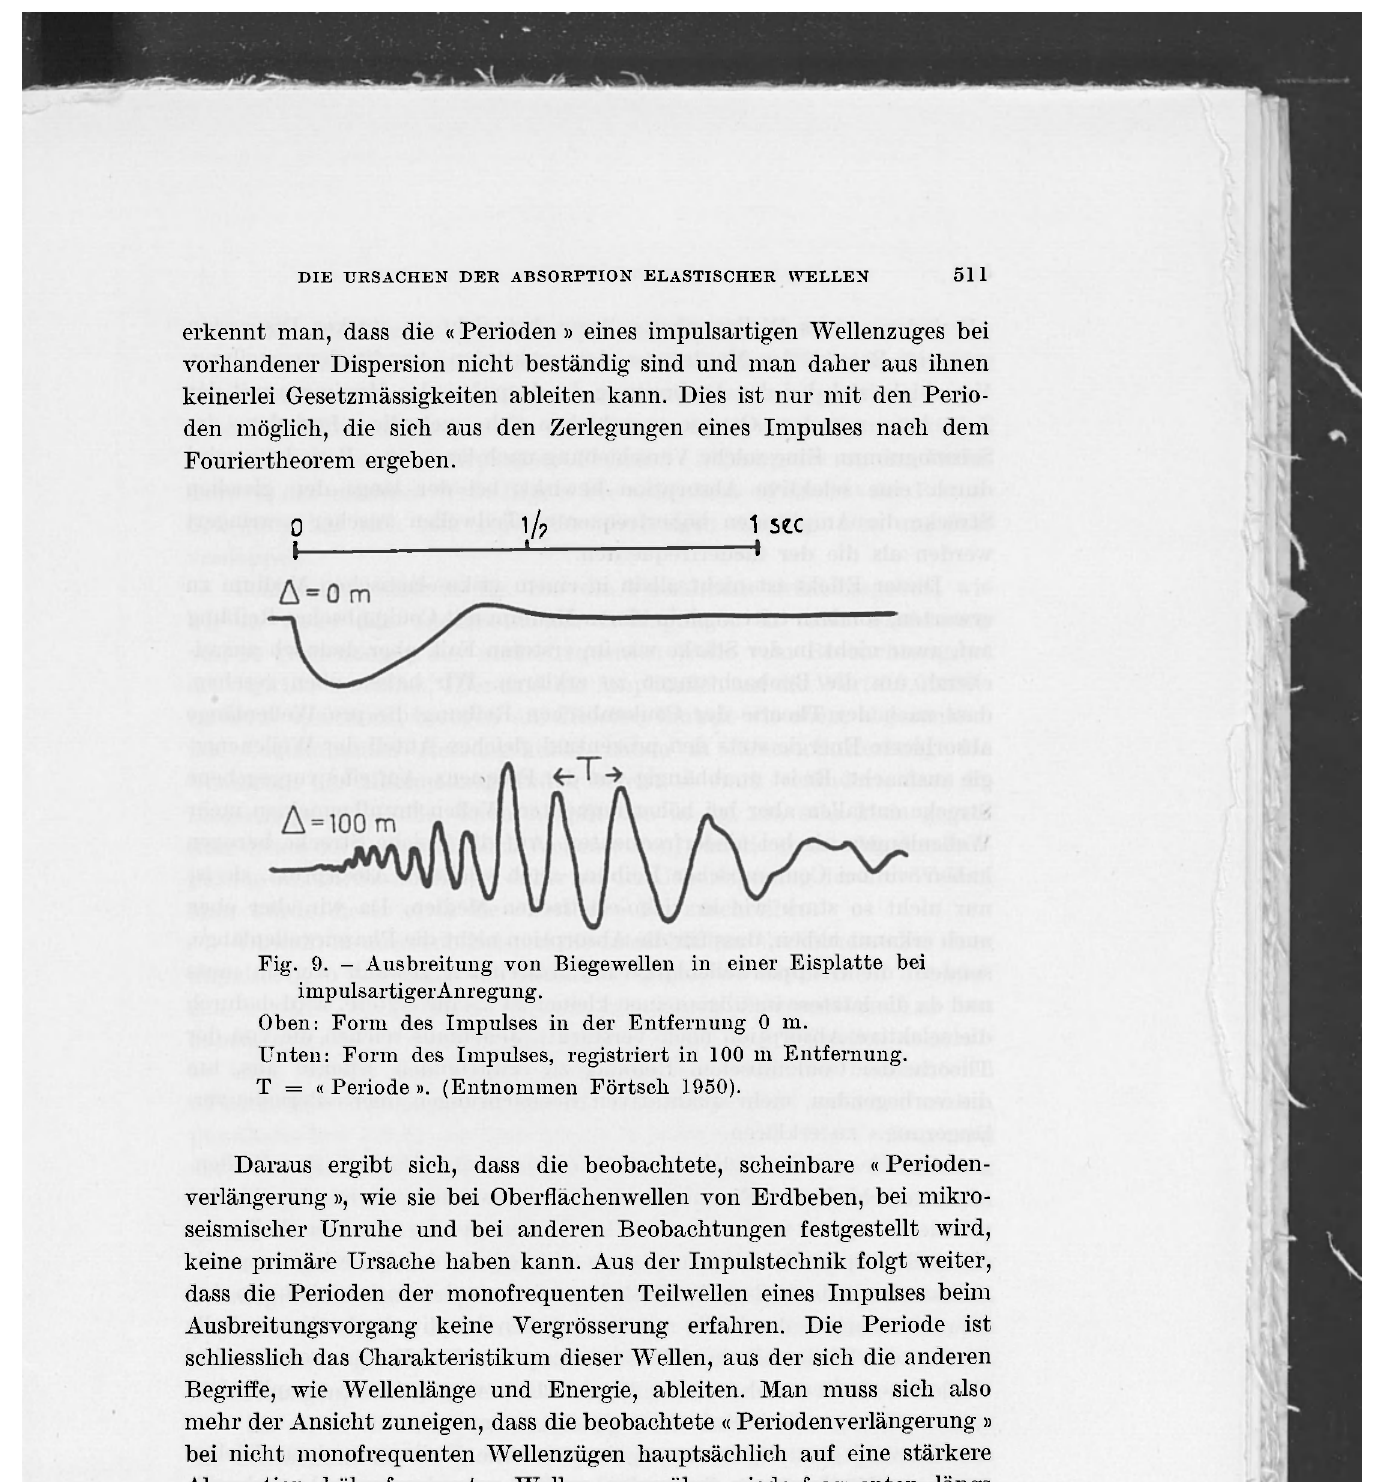
Fig. 9. - Ausbreitung von Biegewellen in einer Eisplatte bei